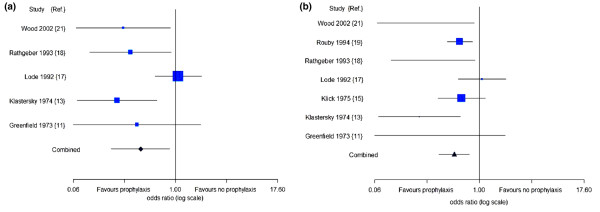
Odds ratios of intensive care unit-acquired pneumonia between patients who received antibiotic prophylaxis via the respiratory tract and those who received placebo or no therapy. (a) Primary analysis (only randomized controlled trials); (b) secondary analysis (including non-randomized trials). Vertical line = 'no difference' point in intensive care unit-acquired pneumonia between the two regimens. Horizontal lines = 95% confidence interval. Square = odds ratio; the size of each square denotes the proportion of information given by each trial. Diamond/triangle = pooled odds ratio for all studies.